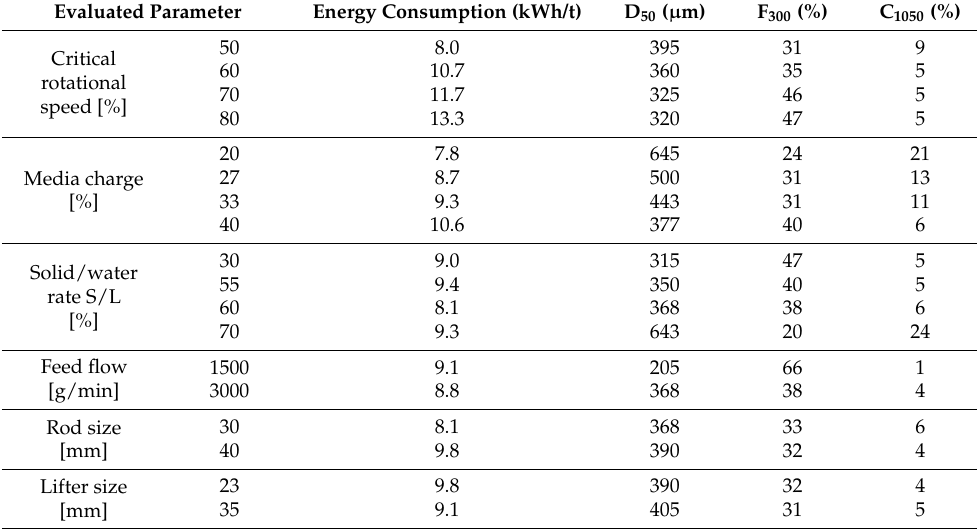
Figure 6. Results of the particle size distribution feed and product of all tests, divided by category, where ( A ) represents V, changing the critical rotation speed, ( B ) represents M, where the media charge was changed, ( C ) represents the curves of S, varying the solid/liquid ratio, ( D ) represents changes in the solid feed flow, ( E ) represents two tests where the rod diameters were changed, and ( F ) represents the lifter heights that were varied. Table 5. Evaluated parameters of experiments with rod